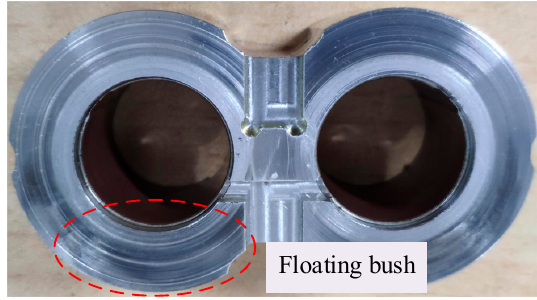
Floating bush Floating bush Figure 21. Gear pump end face wear. Figure 21. Gear pump end face Figure 21. Gear pump end face wear.